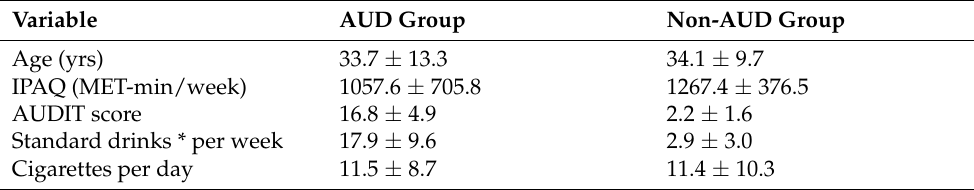
Table 1. Characteristics of the AUD (n = 14) and non-AUD (n = 14) group.